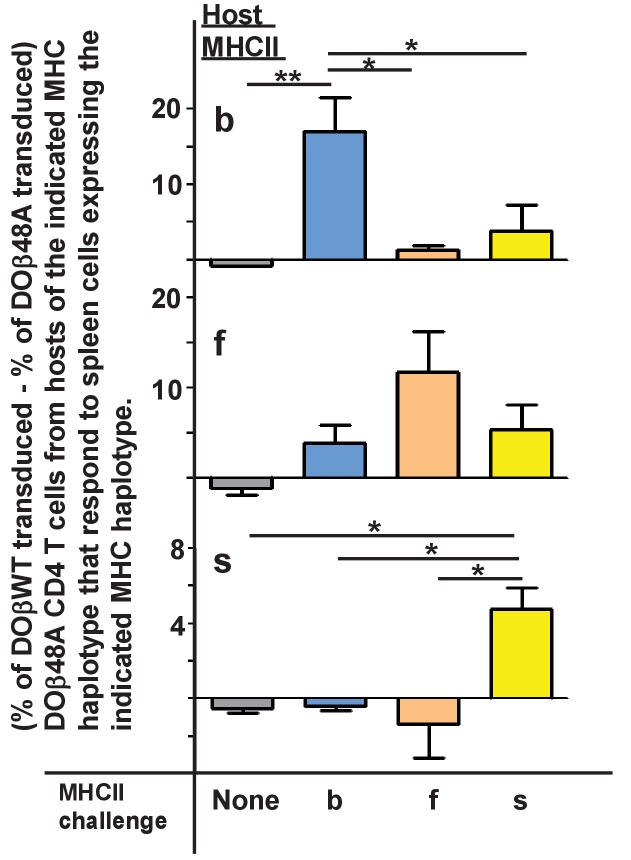
TCRα contributes to the MHCII allele bias of selected naïve CD4 T cells.Naïve CD4 T cells were isolated from the lymph nodes of DOβ48A H2b, f or s mice and incubated for 2 days in wells coated with anti-TCRβ and anti-CD28. Thus activated, the cells were spinfected with GFP-expressing retroviruses expressing also DOβWT or DOβ48A. The cells were cultured for a further 2 days and then challenged with spleen cells from mice expressing the indicated MHC alleles, or in the absence of added spleen cells. One day later the cells were stained for expression of CD69. Results were calculated as the (% of GFP+ T cells transduced with DOβWT-expressing retroviruses that were CD69+) – (the % of GFP+ T cells transfected with DOβ48A-expressing retroviruses that were CD69+) in wells containing the same challenge spleen cells. Shown are the average results ± standard error of the mean (SEM) from three independent experiments. *p<0.05, **p<0.01 by one way ANOVA followed by Neuman Keuls analyses.10.7554/eLife.30918.005Figure 2—source data 1.After transduction with the DObWT chain, T cells from mice expressing DOb48A react with cells bearing the MHC allele that selected them.CD4 T cells were isolated from individual DOb48A mice and transduced with retorviruses expressing DObWT or DOb48A as described in the Methods section. The cells were vultured with spoleen cells from mice expressing various MHC alleles and responses assessed one day later by measuring the % of cells that bore CD69. Data shown are from individual mice assayed on different days.